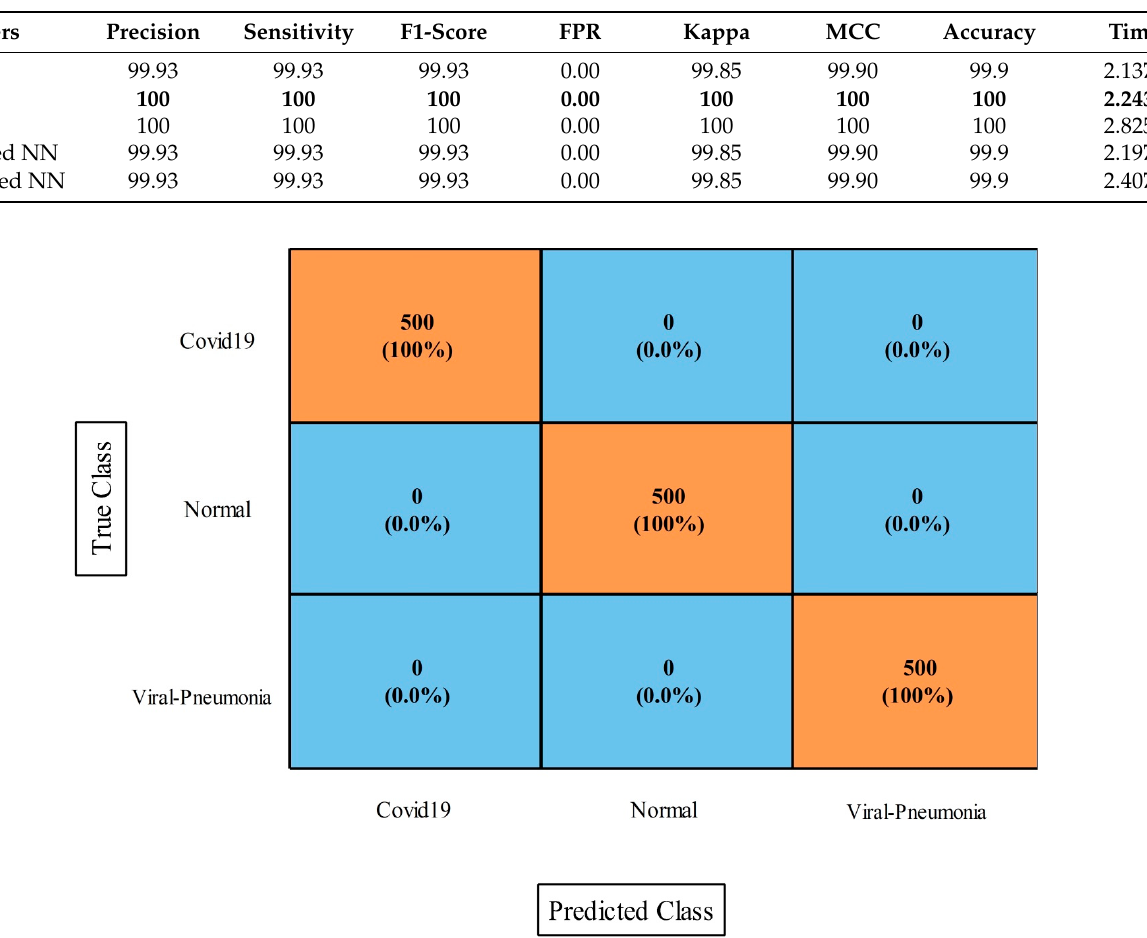
Table 11. Proposed ICCA fusion approach results on COVID-19 Detection dataset.